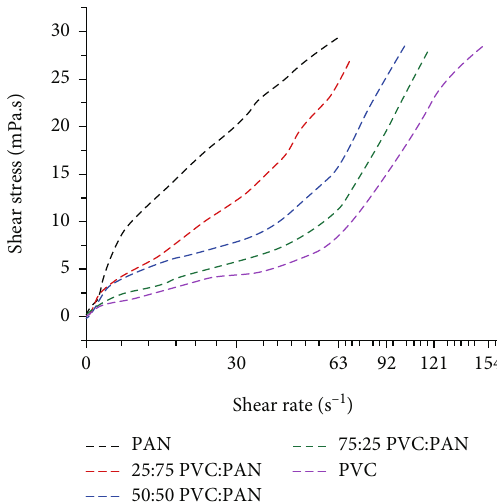
Figure 2: Shear stress-shear rate curves for pure polymers and di ff erent PVC: PAN blending ratio solutions.